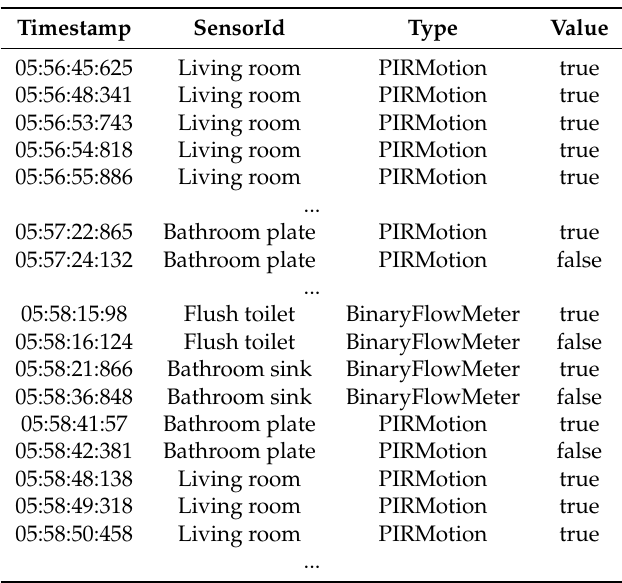
Table 8. Sample of the binary sensors dataset generated by our example. The first column is the timestamp, the second column provides the sensor name, the third shows the type of sensor, and the last column shows the state of the sensor at the current